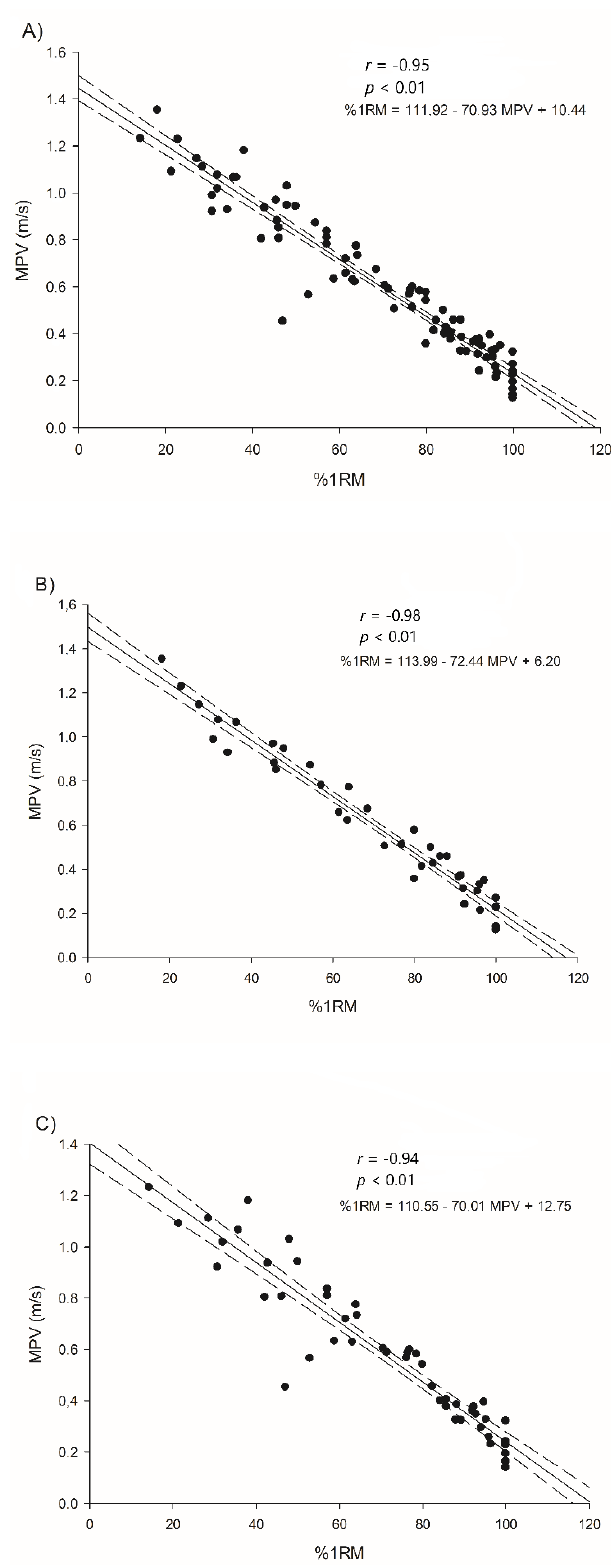
Figure 1. Relationships between the %1RM and the MPV of the results obtained in the pretest by all the players ( A ), the IWBF < 2.5 group ( B ), and the IWBF > 2.5 ( C ) group. r = Pearson correlation coefficient; p < 0.01 significant correlations between %1RM and the MPV; p < 0.001 significant correlations between %1RM and the MPV.